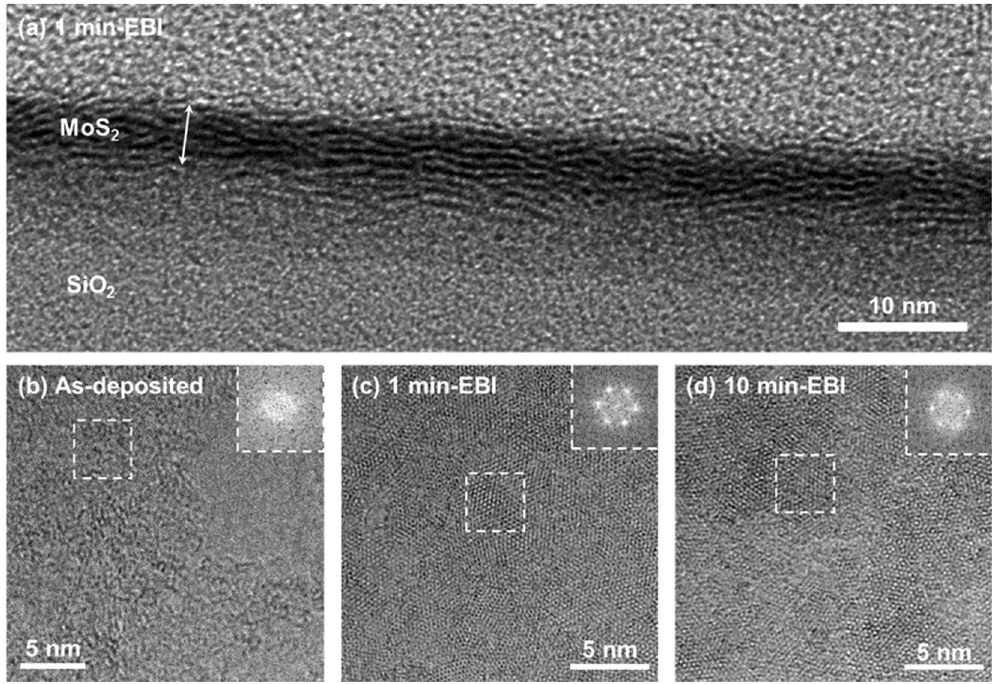
Figure 3. HR-TEM images of EBI-treated MoS 2 films. ( a ) Cross-sectional HR-TEM image of 1 min EBI-treated MoS 2 film. Plan-view HR-TEM images of the ( b ) as-deposited sample, ( c ) 1 min EBI-treated sample, and ( d ) 10 min EBI-treated sample. Insets show FFT patterns of the areas marked as dashed